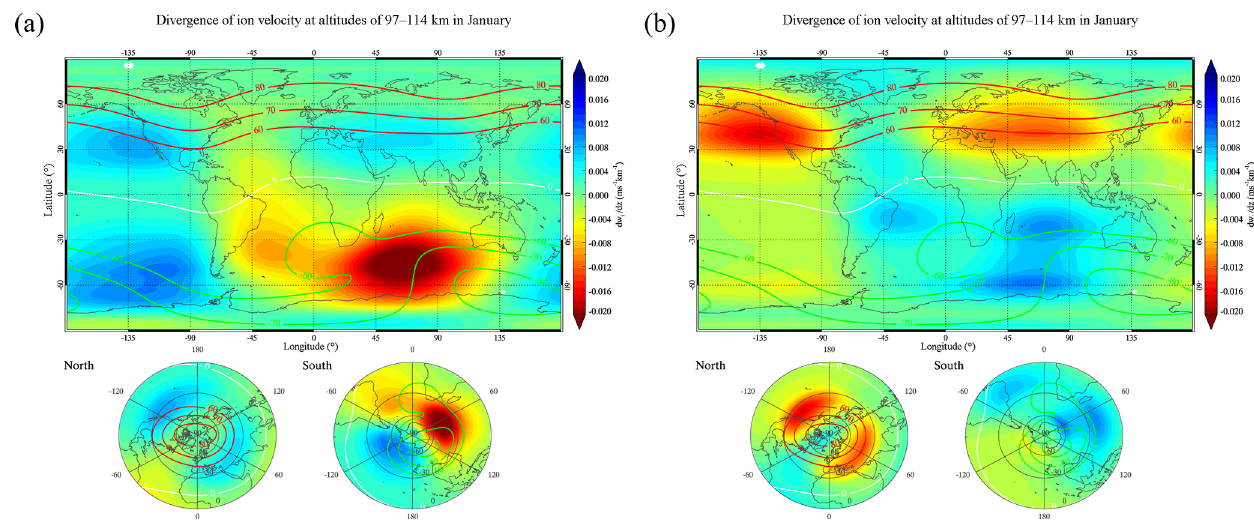
Figure 10. Same as Fig. 8 but with the consideration of the effect of the magnetic declination angle on the vertical ion velocity in January (a) and July (b)